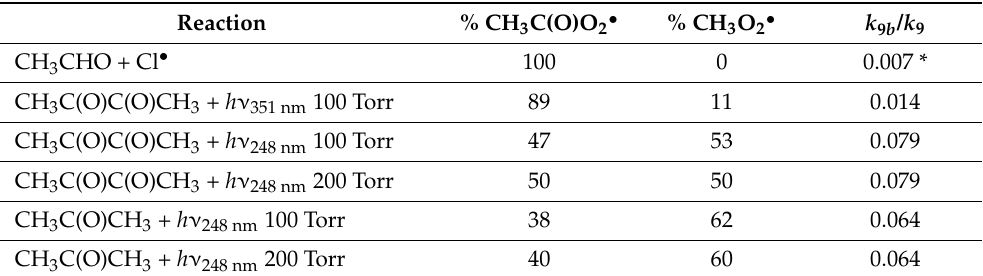
Table 2. Ratio of CH 3 C(O)O 2 • and CH 3 O 2 • radicals obtained from different precursors and at different pressures. Last column shows fraction of CH 3 CO radicals that lead in collision with O 2 to HO 2 radicals